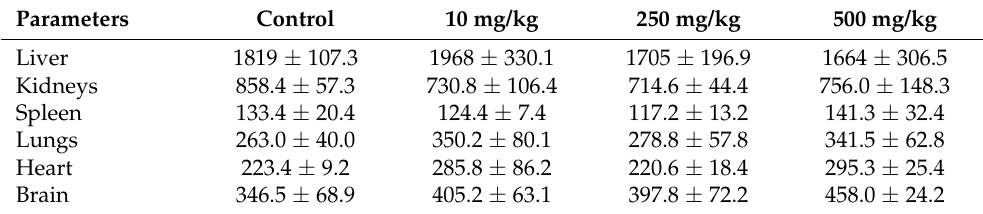
Table 1. Relative organ weight (mean ± SD) of PsA versus control-treated male Swiss albino mice. After being excised, intact organs were dabbed with a cloth to remove excess blood and immediately weighed. Kidneys and lungs were weighed together. Data shown as mean ± SD for n = 5/sex/group. Parameters